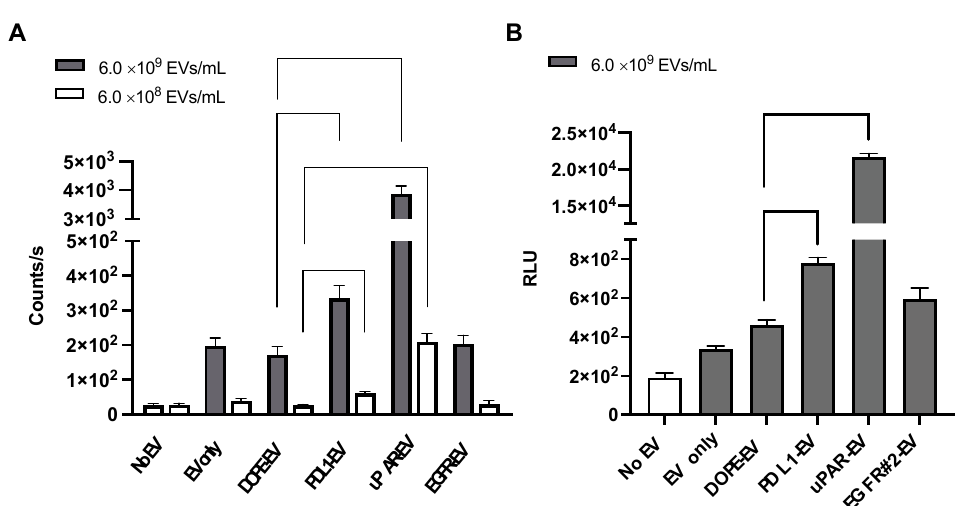
Figure 3. Bioluminescence analysis of cellular uptake of THP-engineered PalmReNL-EVs. ( A ) Bioluminescence analysis of the recipient MDA-MB-231 cells cultured with two different concentrations (6.0 × 10 8 and 6.0 × 10 9 EVs/mL) of THP-engineered PalmReNL-EVs using furimazine. ( B ) Bioluminescence analysis of cellular uptake of PalmReNL-EVs (6.0 × 10 9 EVs/mL) engineered with the EGFR-binding peptide #2, together with PalmReNL-EVs bearing PDL1-, uPAR-binding peptides, or DOPE-lipid nanoprobes only. ( A - B ) Error bars, SD ( n = 5); two-sided Student’s t -tests was used for comparison.